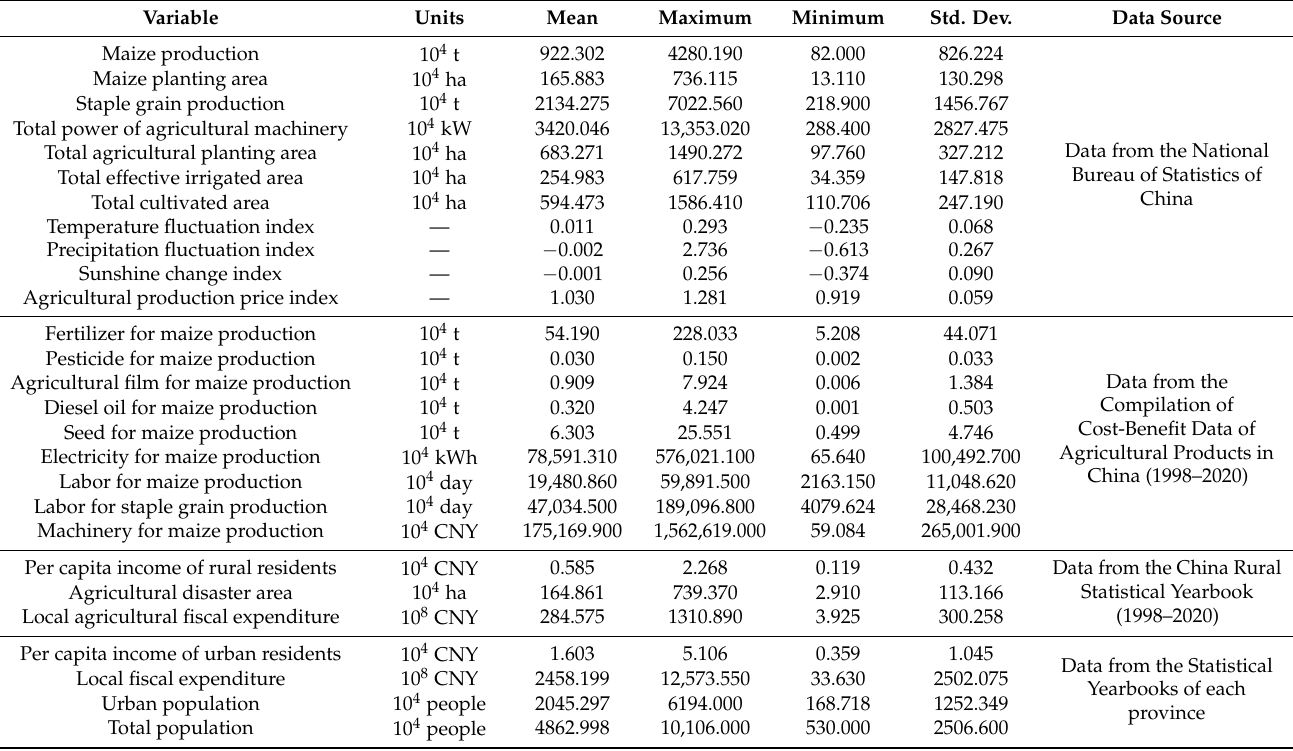
Table 2. Data sources and descriptive statistics of